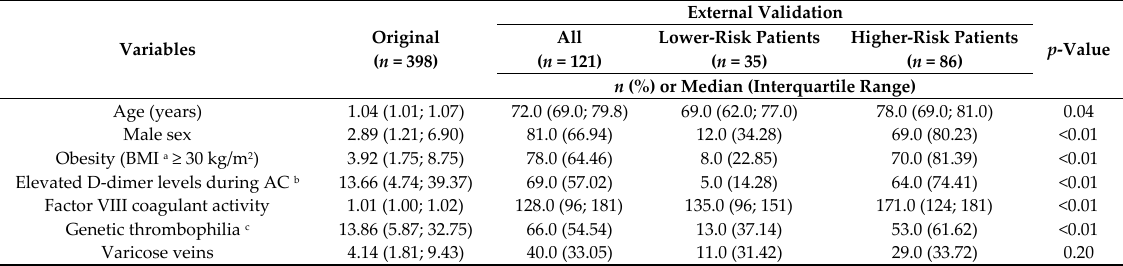
Table 1. Comparison of baselines characteristics in the development and validation